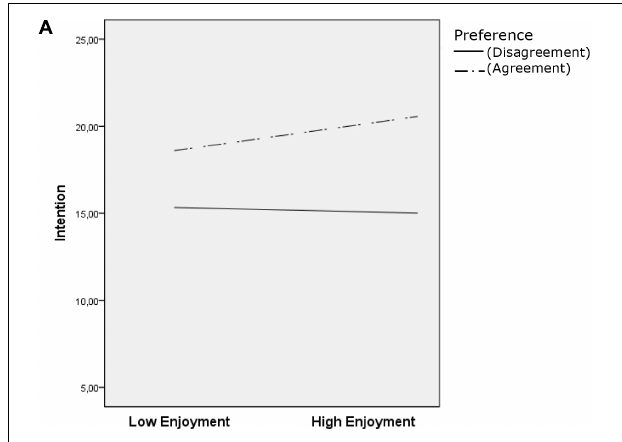
FIGURE 2 | Conditional effects analysis for the preference level of agreement/disagreement on intention to continue